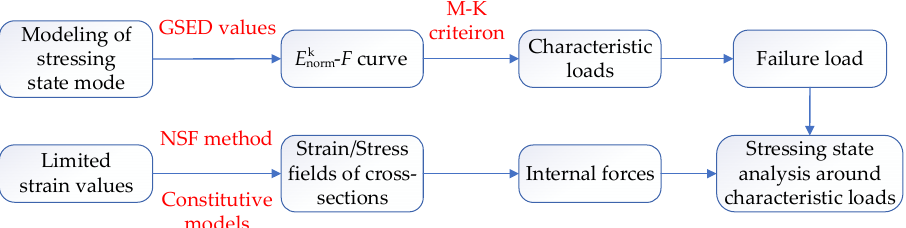
Figure 2. Stressing state analysis idea of the PCTLCC box girder bridge.